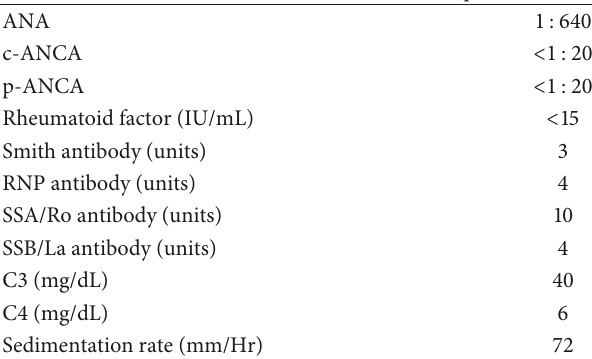
Figure 1: Paravertebral soft tissue mass (a) before and (b) after treatment with prednisone. Table 1: Baseline autoimmune workup.